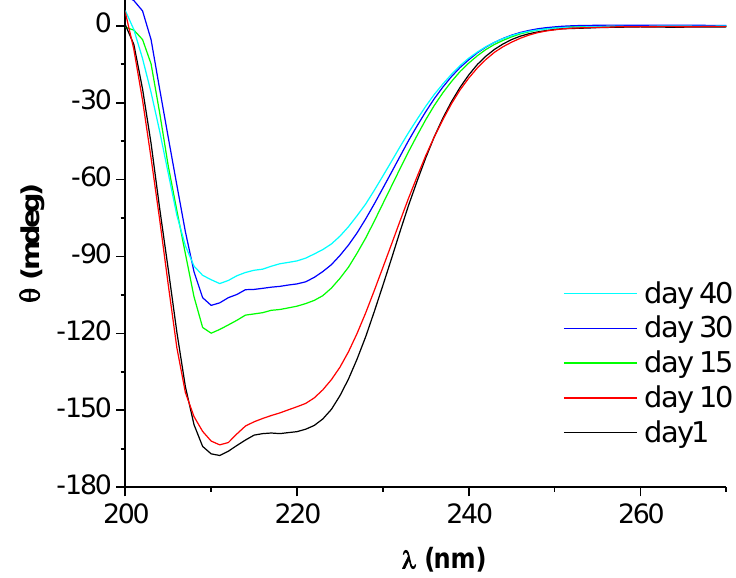
Figure 4. Circular dichroism spectra of BSA (2 mg / mL) recorded at various time intervals and evidencing the alteration of the BSA secondary structure upon gold nanoparticle formation and growth; [HAuCl 4 ] = 2 × 10 −3 M.